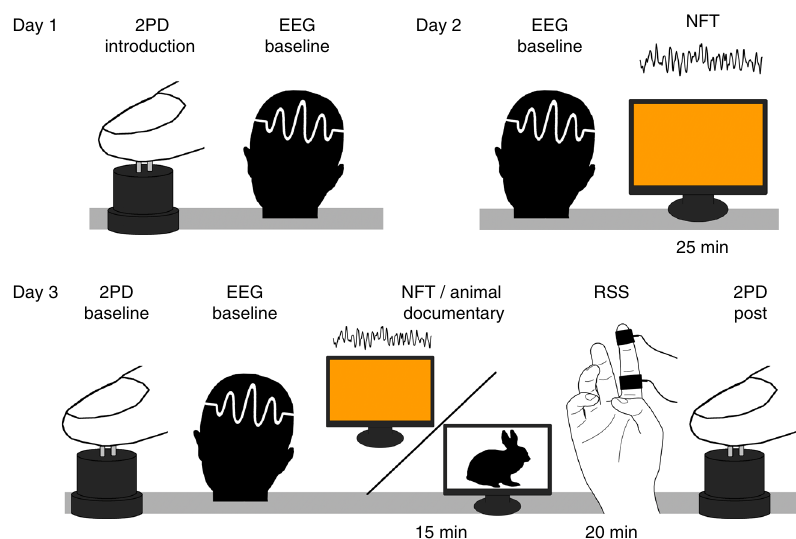
Fig. 5 Experimental schedule. Display of the experimental schedule over three subsequent days. Day one started with an introductory tactile